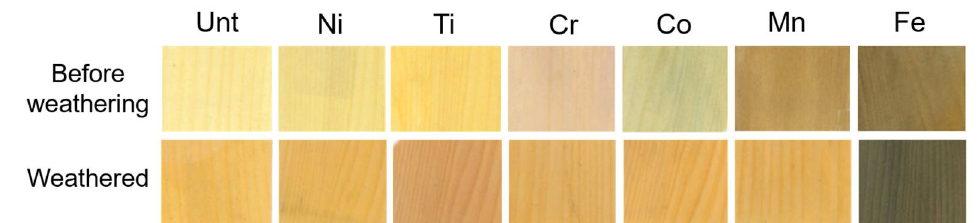
Figure 5. Color of yellow cedar veneers treated with different acetylacetonates before and after exposure to the weather for 20 days in Australia.